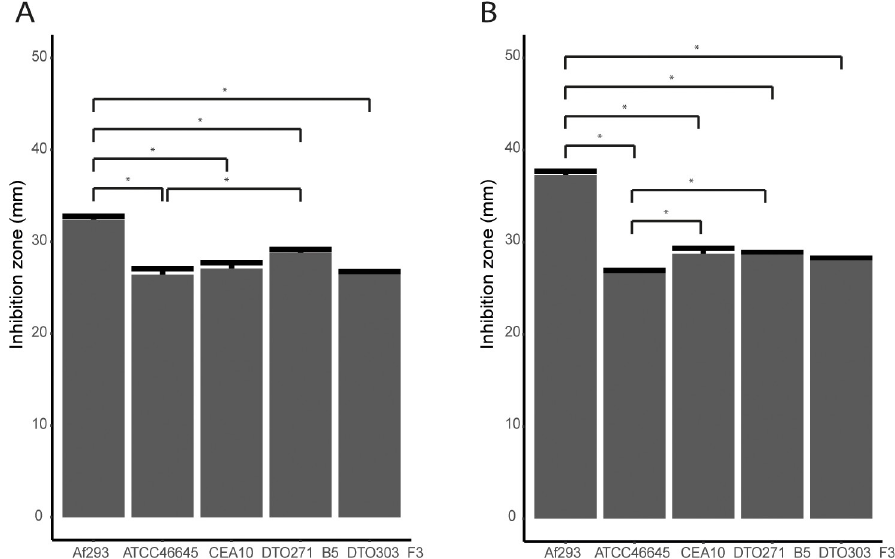
Fig 2. Oxidative stress resistance of A . fumigatus strains. Sensitivity of five A . fumigatus isolates for hydrogen peroxide (A, 500 mM H 2 O 2 ) (A) or menadione (B, 1 mM Menadione) as determined in an agar plate diffusion assay. Bars represent the average inhibition zone based on biological and technical triplicates ( ± SE). � indicates statistical significance, based on a one-way ANOVA with a p-value � 0.05.